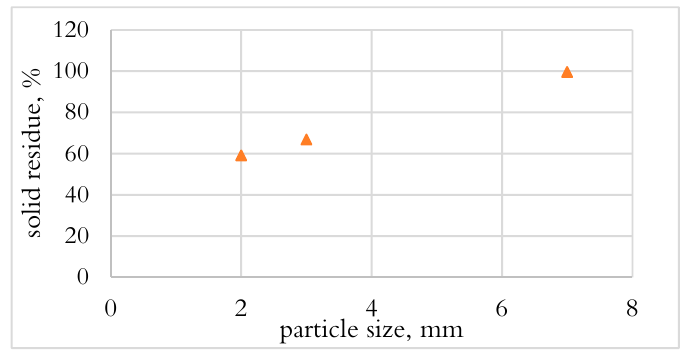
ff erent particle sizes at 1250 ◦